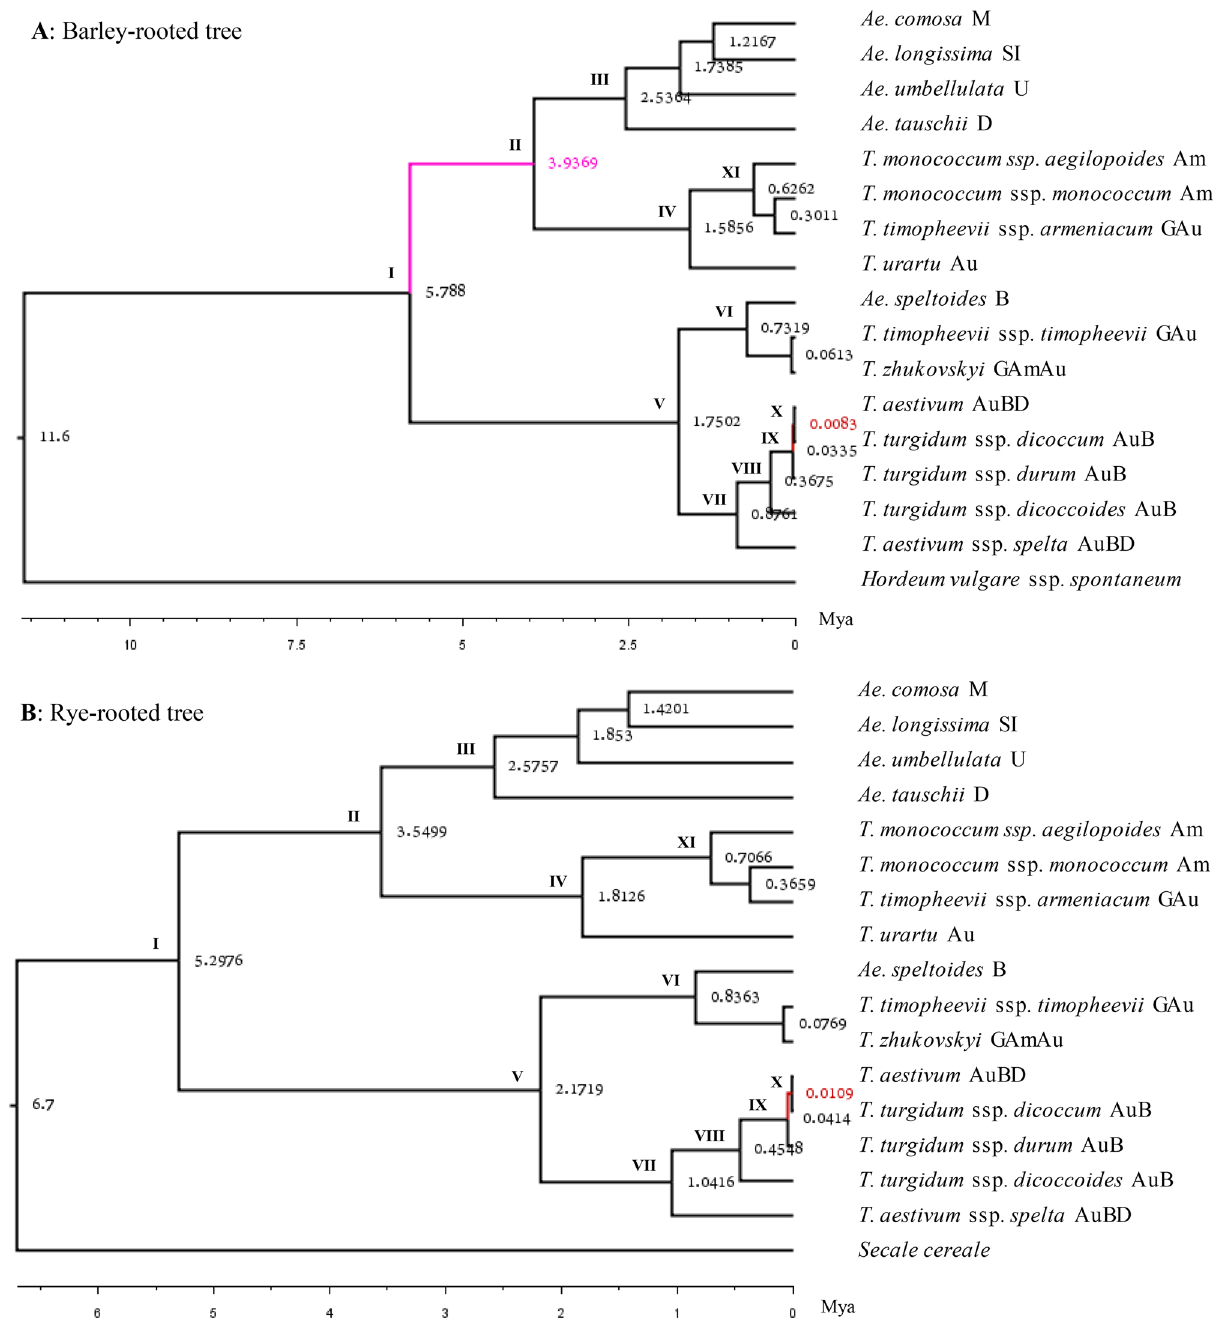
Figure 3. Maternal phylogenetic trees of 16 samples representing six Triticum and five Aegilops species with node age and support, as inferred from chloroplast sequence variations using BEAST software. The top ( A ) and bottom ( B ) trees were rooted with wild barley ( Hordeum vulgare ssp. spontaneum ) and rye ( Secale cereale ), respectively. The node ages were calibrated with the root ages in Mya following the related age estimates by Chalupska et al . 14 . All the nodes had supports with posterior probability of 0.99 or higher, except one node in purple and two nodes in red with the posterior probabilities of 0.89 and 0.33, respectively. Eleven major nodes are labeled and the sample is labeled with its nuclear genome